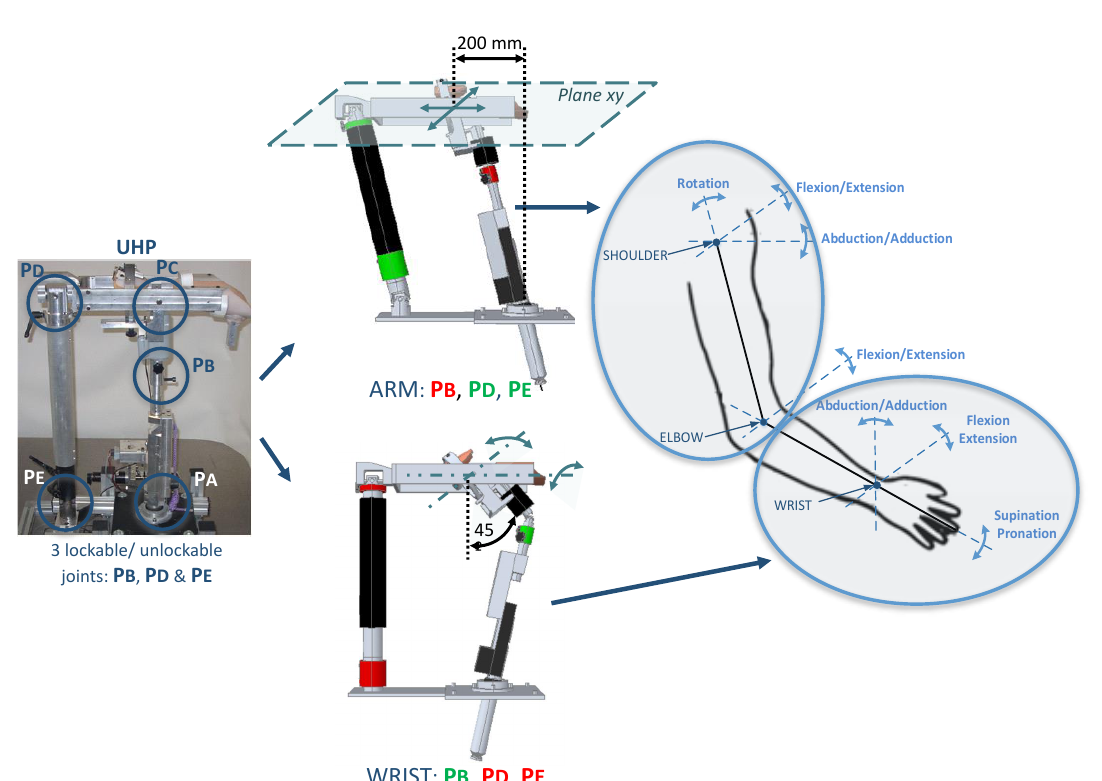
Figure 1. ARM and WRIST operating modes of the UHP rehabilitation robot (Red color denotes locked joint, Green color denotes unlocked